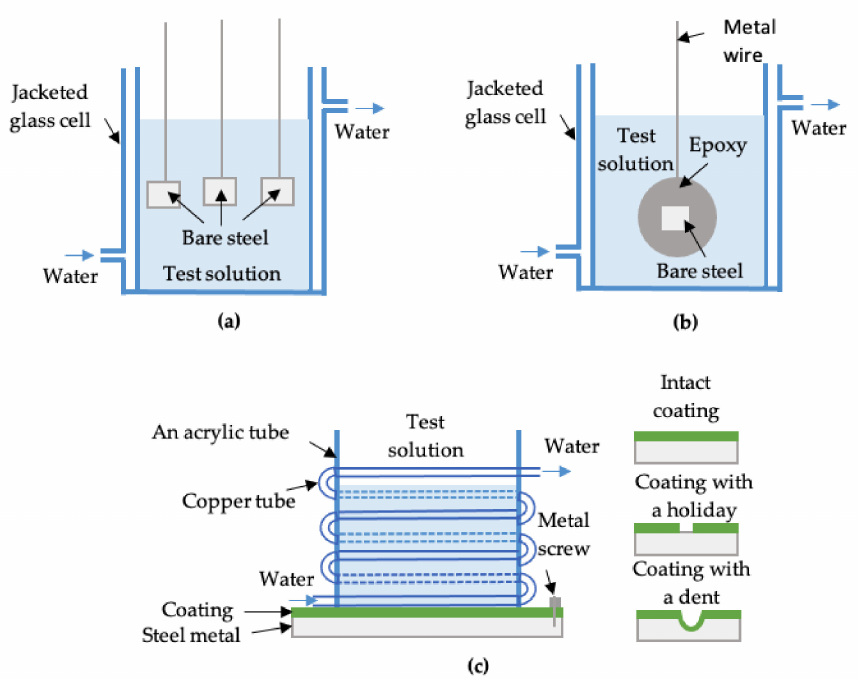
Figure 1. A schematic of ( a ) 1.5 cm 2 bare electrodes for weight loss tests; ( b ) a 1 cm 2 bare electrode for electrochemical tests (EIS); and ( c ) a coated X60 panel sample for corrosion immersion and electrochemical